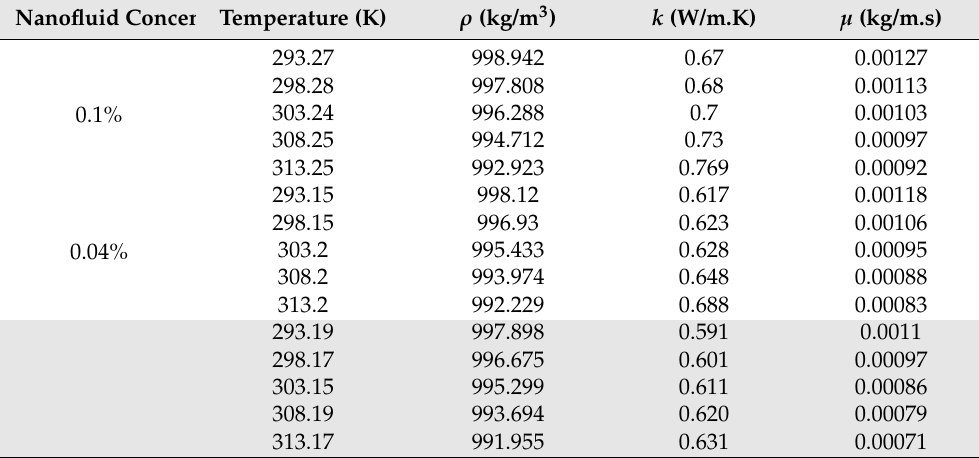
Table 4. Thermophysical characteristics of water and hybrid nanofluid at various temperatures [34]. Nanofluid Concentration ( ϕ )Temperature (K) ρ (kg/m 3 ) k (W/m.K) µ